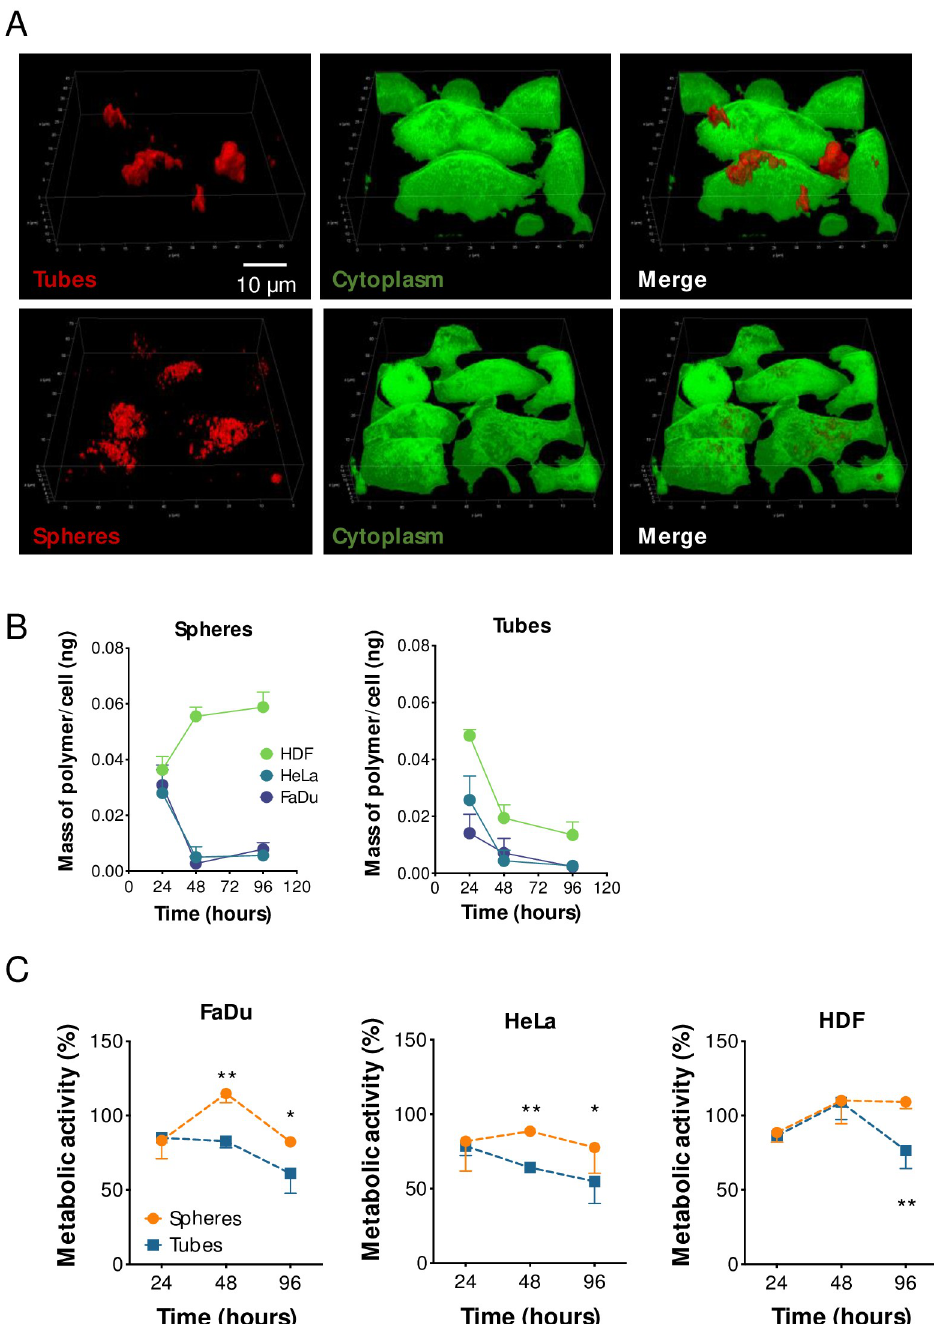
Fig 2. Cellular uptake of spheres and tubes. (A) Confocal imaging showing the complete internalization of spheres after 96 hours incubation with FaDu cells and the “frustrated” uptake of the tubes. Green is Calcein staining of the cytoplasm. (B) HPLC-based quantification of the mass of polymer per cell over time in either FaDu, HeLa or HDF cells. (C) Viability assay on FaDu, HeLa, or HDF cells incubated with spheres or tubes for 24, 48 or 96 hours. Two-way ANOVA. � = p < 0.05, �� = p < 0.01. n = 3 independent experiments.